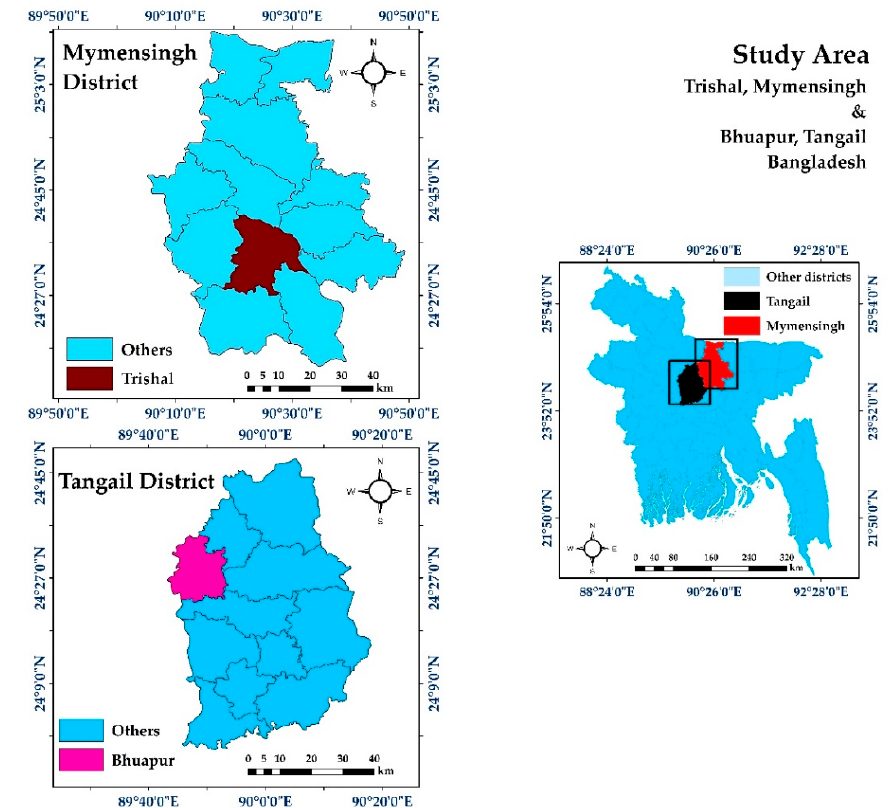
Figure 2. Map of the study area. Images were extracted from DIVA-GIS using Geographical Information System (GIS). The map was developed using ArcMap version 10.7.